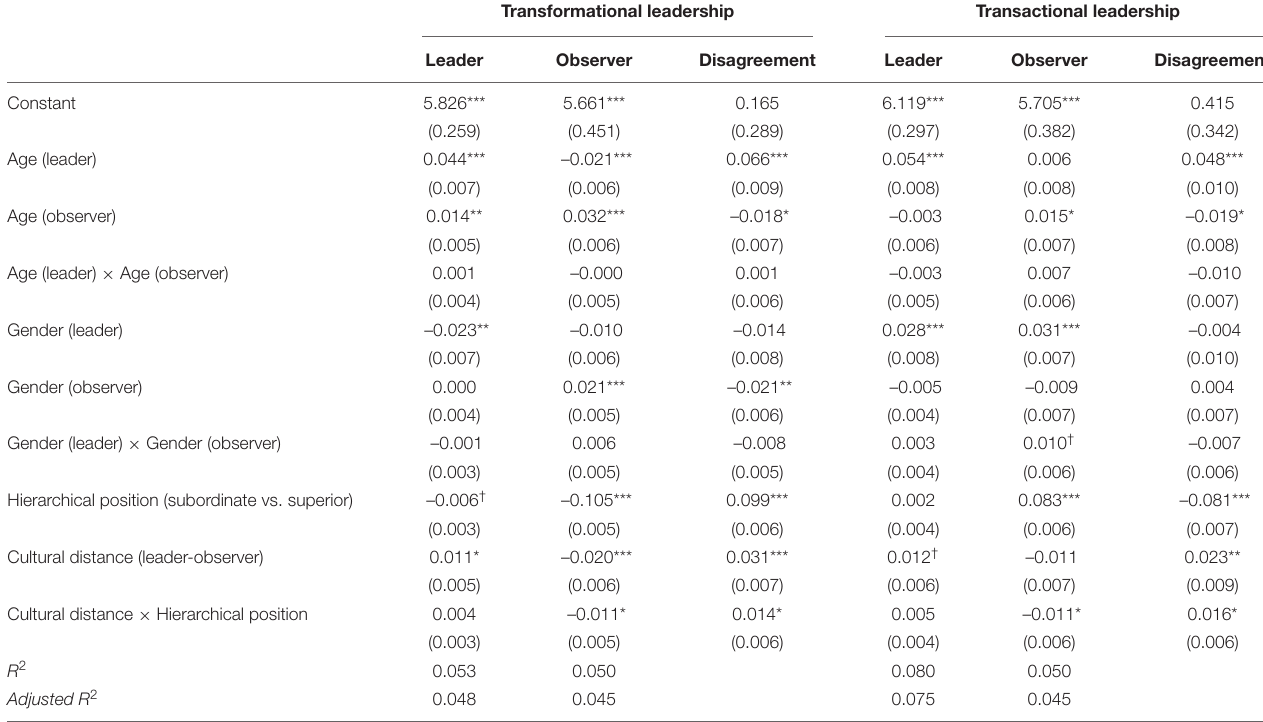
TABLE 4 | Multivariate regressions and Wald tests for leader-observer dyads.